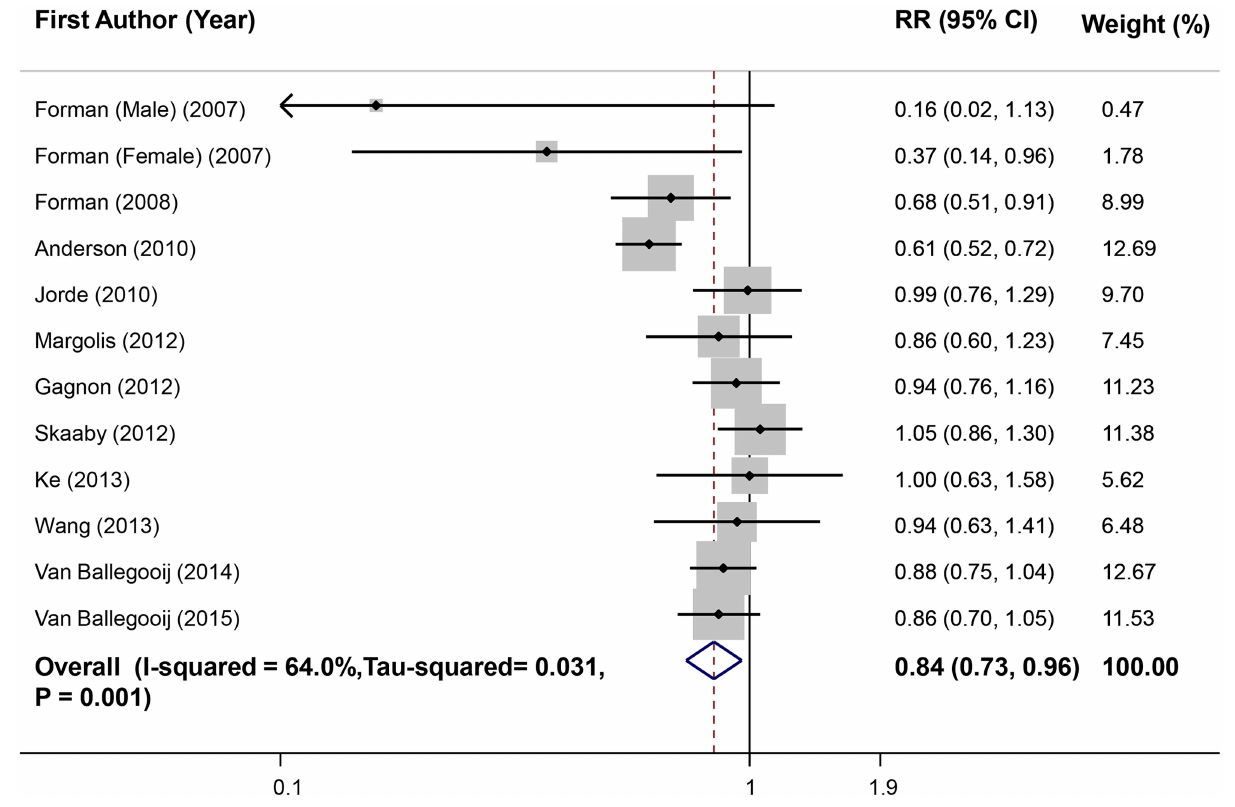
for publication bias (Begg’s test = 0.49, Egger’s test = 0.64) ( Supplementary Figure 1A ).